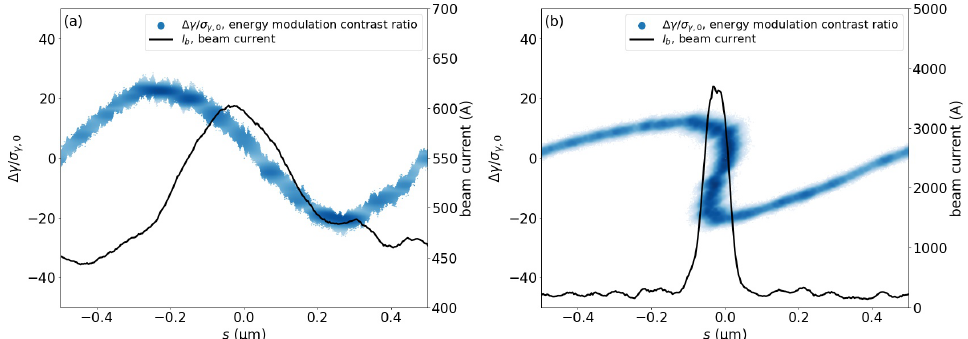
Figure 8. Longitudinal phase space of the electron beam plotted in the form of the energy modulation contrast ratio ∆γ / σ γ ,0 vs. the relative longitudinal coordinate, and beam current plotted within one laser wavelength (1 µ m), ( a ) before and ( b ) after the bunch compression by BC2. Within each energy modulation period by the laser modulator, BC2 converts the energy modulation into the longitudinal electron density modulation, enhancing the average beam current of 500 A prior to BC2 to a current spike of 3 kA downstream of BC2. Note that the modulation amplitude after BC2 decreased due to the increase in the uncorrelated energy spread by the ISR effect in